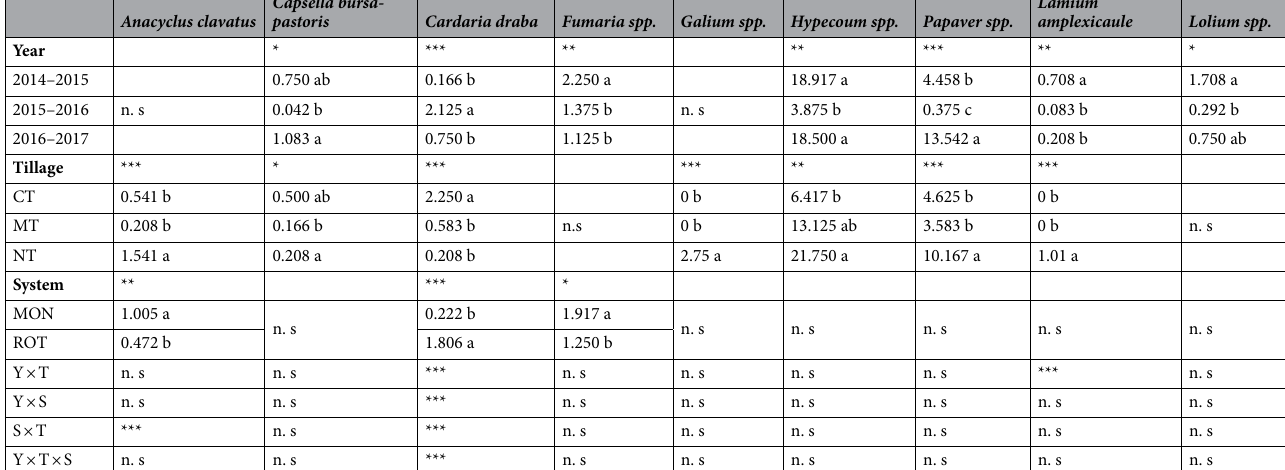
Table 5. Analysis of variance results for years, tillage system, and crop system for weed density. Mean values for nine main weed species. Different letters in each column indicate a difference between treatments according to HSD Tukey’s Test with 95% probability level ( p < 0.05); *** = 0.05; ** = 0.1; * = 0.5 CT conventional tillage, MT minimum tillage, NT no tillage, ROT rotation, MON monoculture, Y year, T tillage, S system.